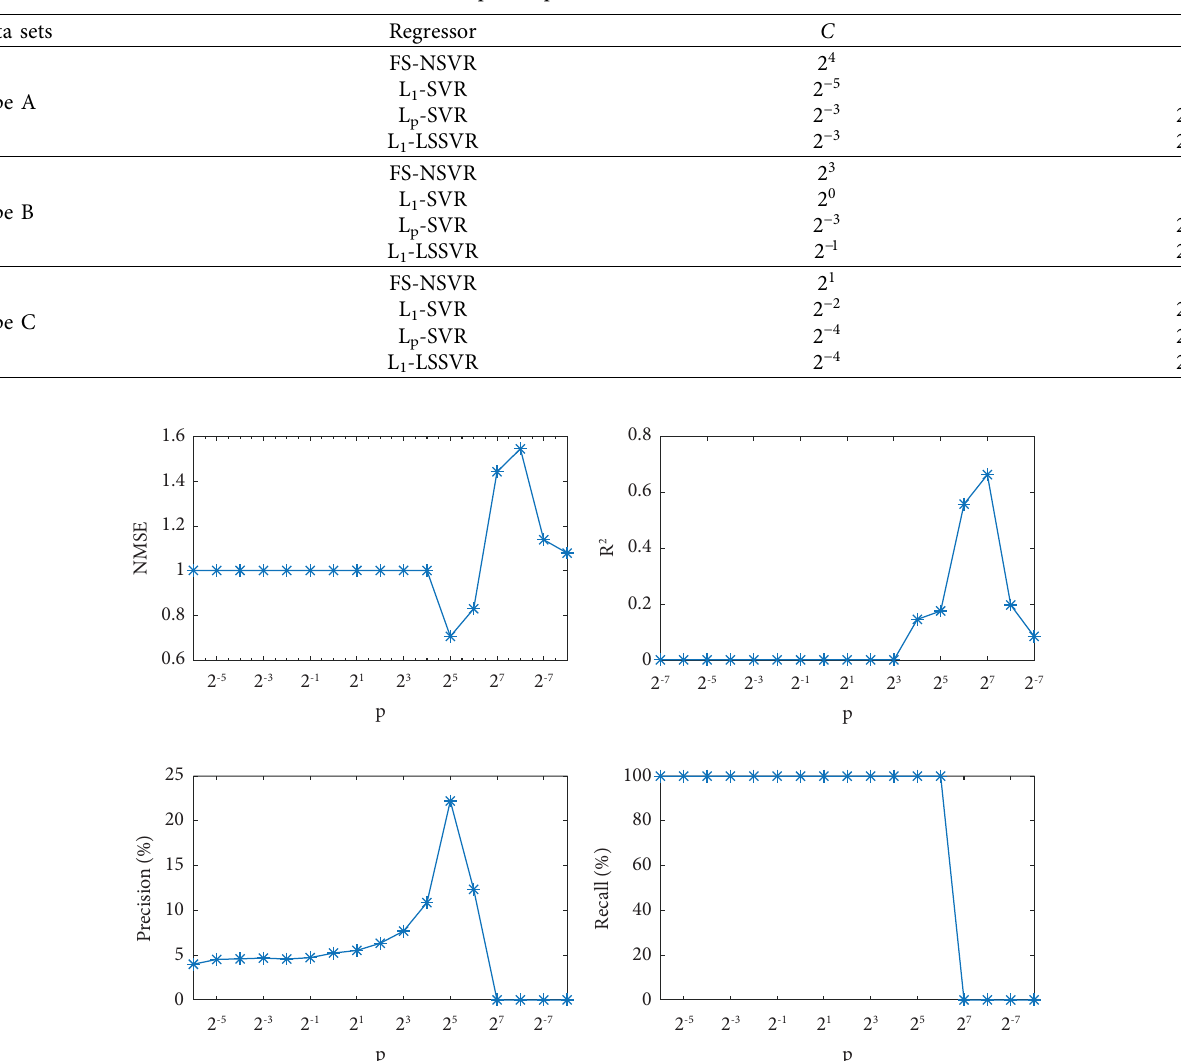
Table 2: Te optimal parameters of artifcial